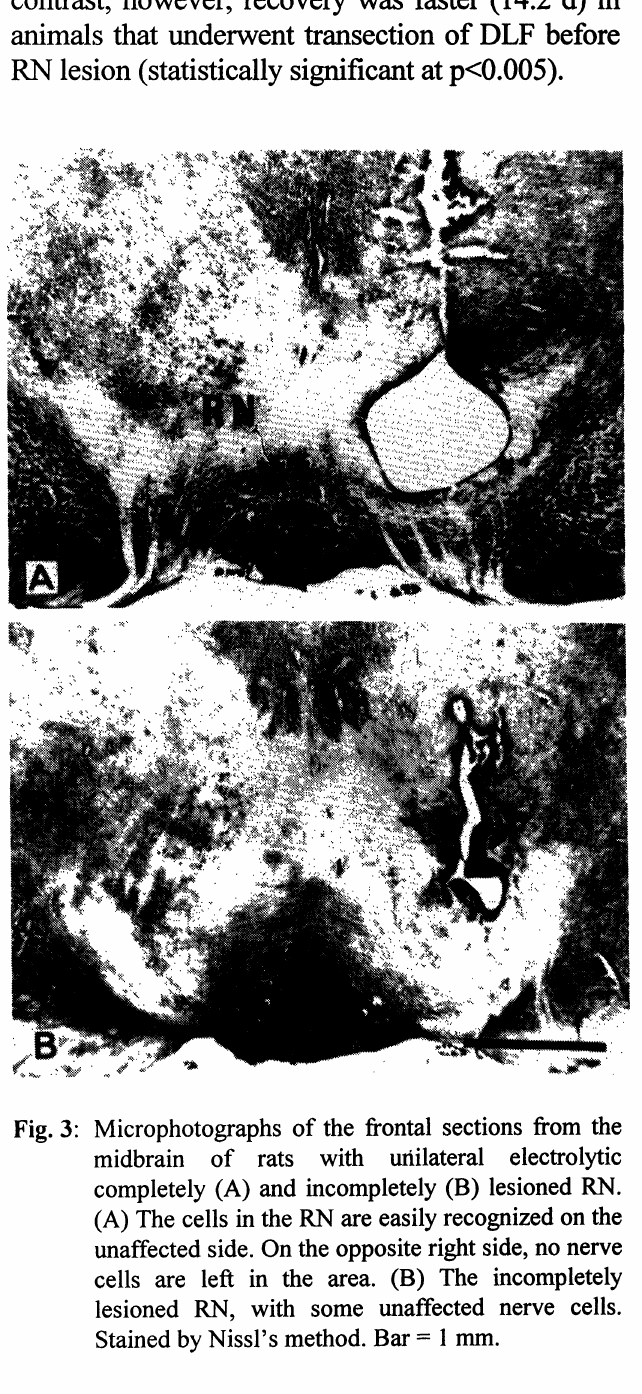
Fig. 3: Microphotographs of the frontal sections from the midbrain of rats with uriilateral electrolytic completely (A) and incompletely (B) lesioned RN. (A) The cells in the RN are easily recognized on the unaffected side. On the opposite right side, no nerve cells are left in the area. (B) The incompletely lesioned RN, with some unaffected nerve cells. Stained by Nissl’s method. Bar